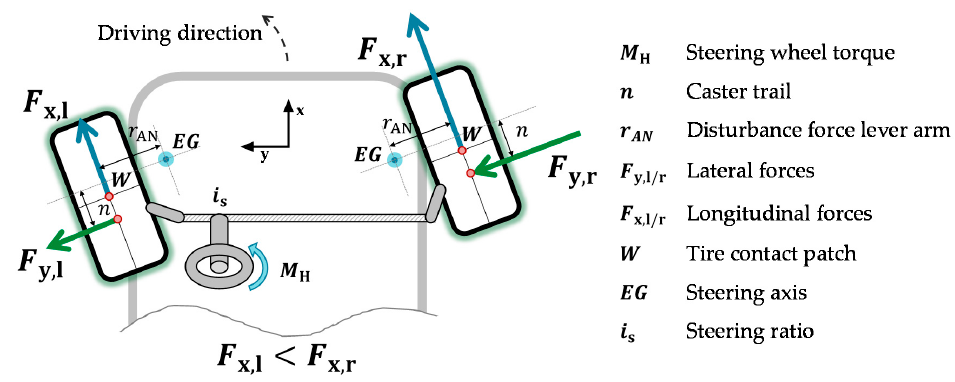
Figure 1. Functioning principle of power steering by wheel ‐ individual drives.